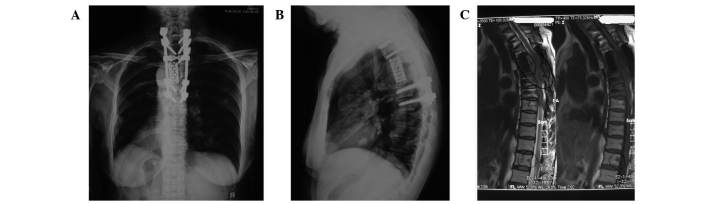
Image examination results of a patient two years after posterior vertebral column resection. (A) Anterior-posterior and (B) lateral X-rays of the thoracic spine two years after surgery; (C) magnetic resonance imaging of the thoracic spine two years after surgery showed local recurrence and a new lesion at T12 (original lesion located at T4 and T5).